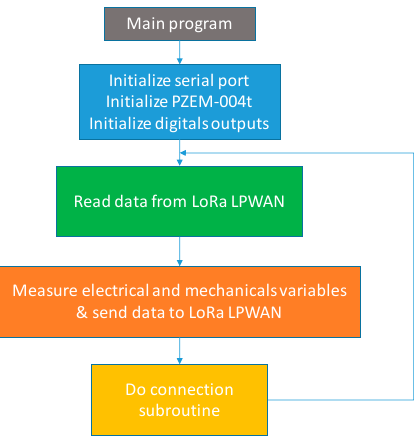
Figure 5. IMEMSL main program.